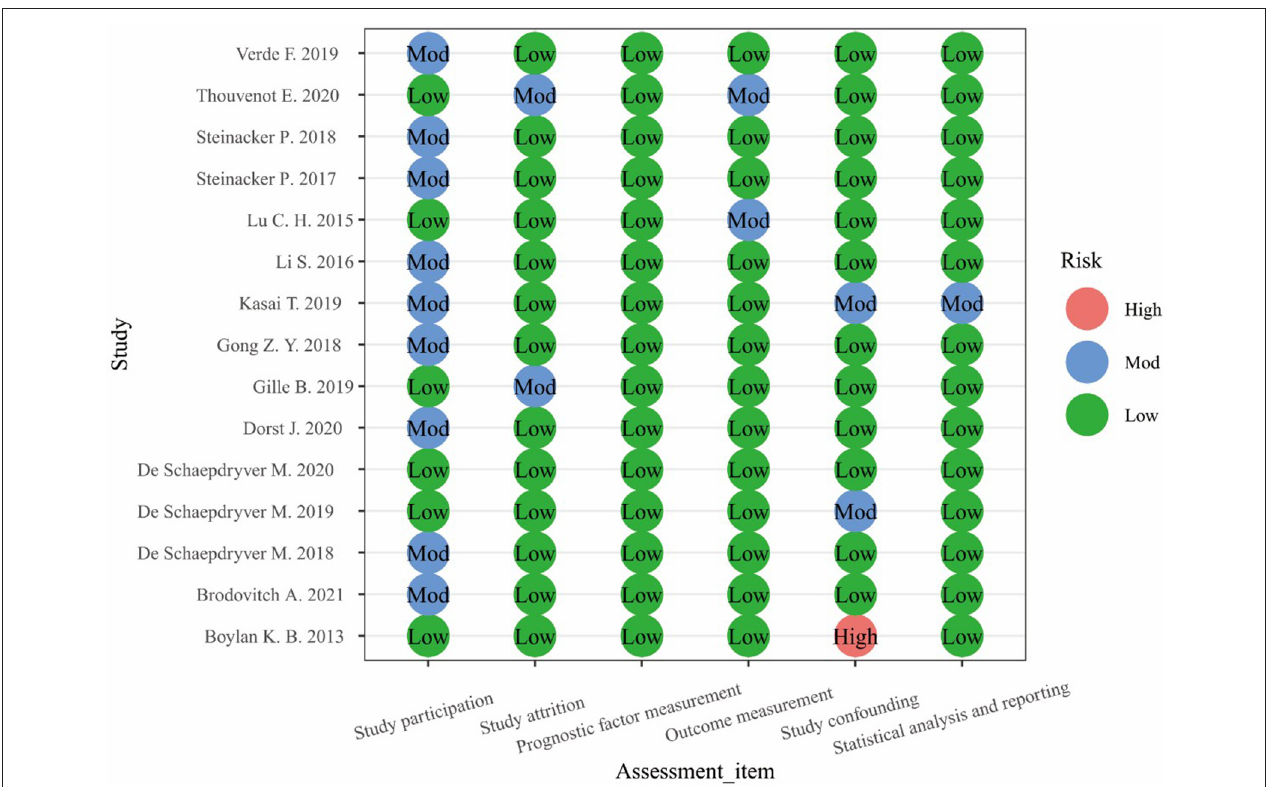
FIGURE 2 | Quality evaluation